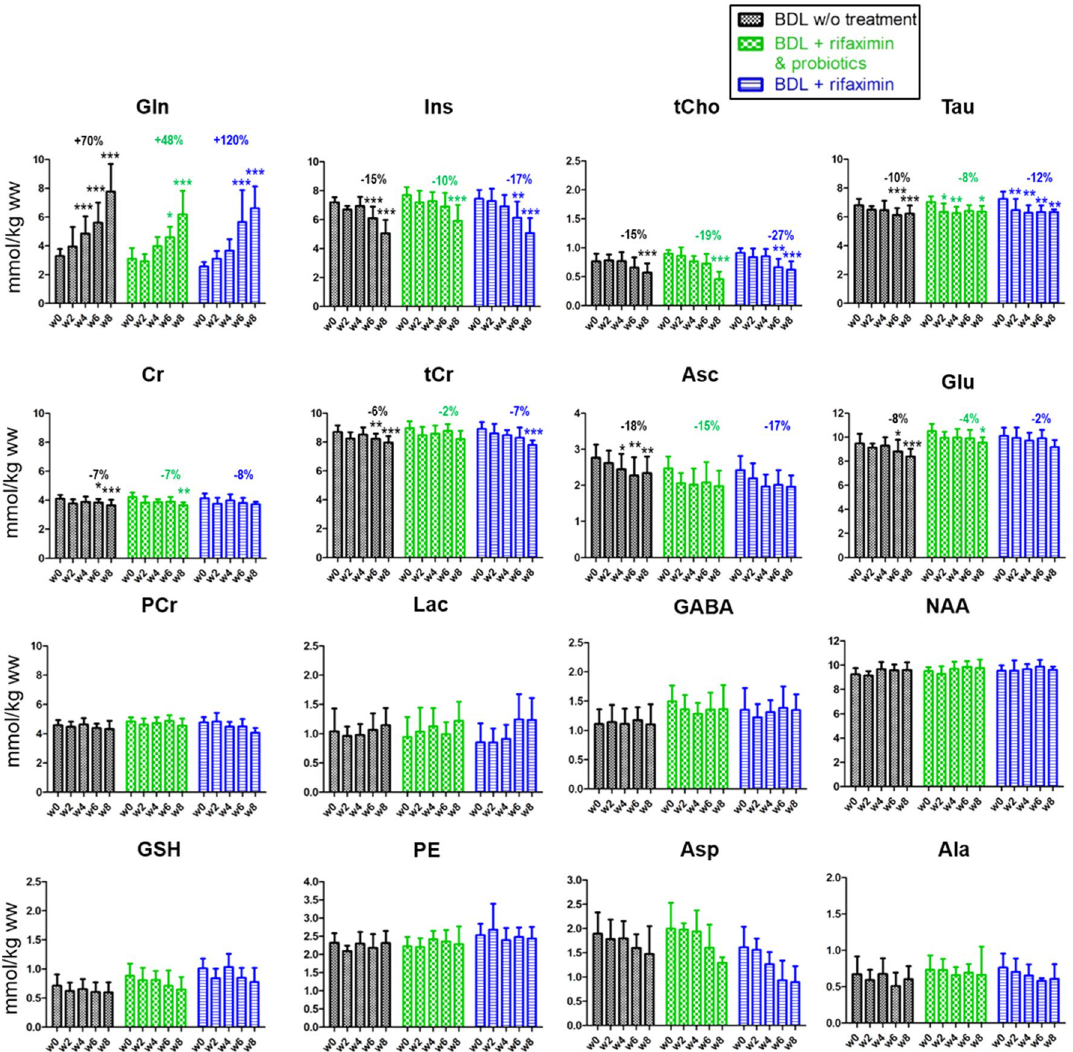
Figure 4. Longitudinal 1 H MRS data of brain metabolites in the hippocampus region of the ‘rifaximin’ treated group, the ‘rifaximin + probiotics’ treated group and the group without treatment. For better readability, relative changes indicated in the graph are shown only at week 6 relative to week 0 and are indicated for metabolites whose concentrations significantly varied over time. Statistical significance: One-way ANOVA (* p < 0.05; ** p < 0.01; *** p <